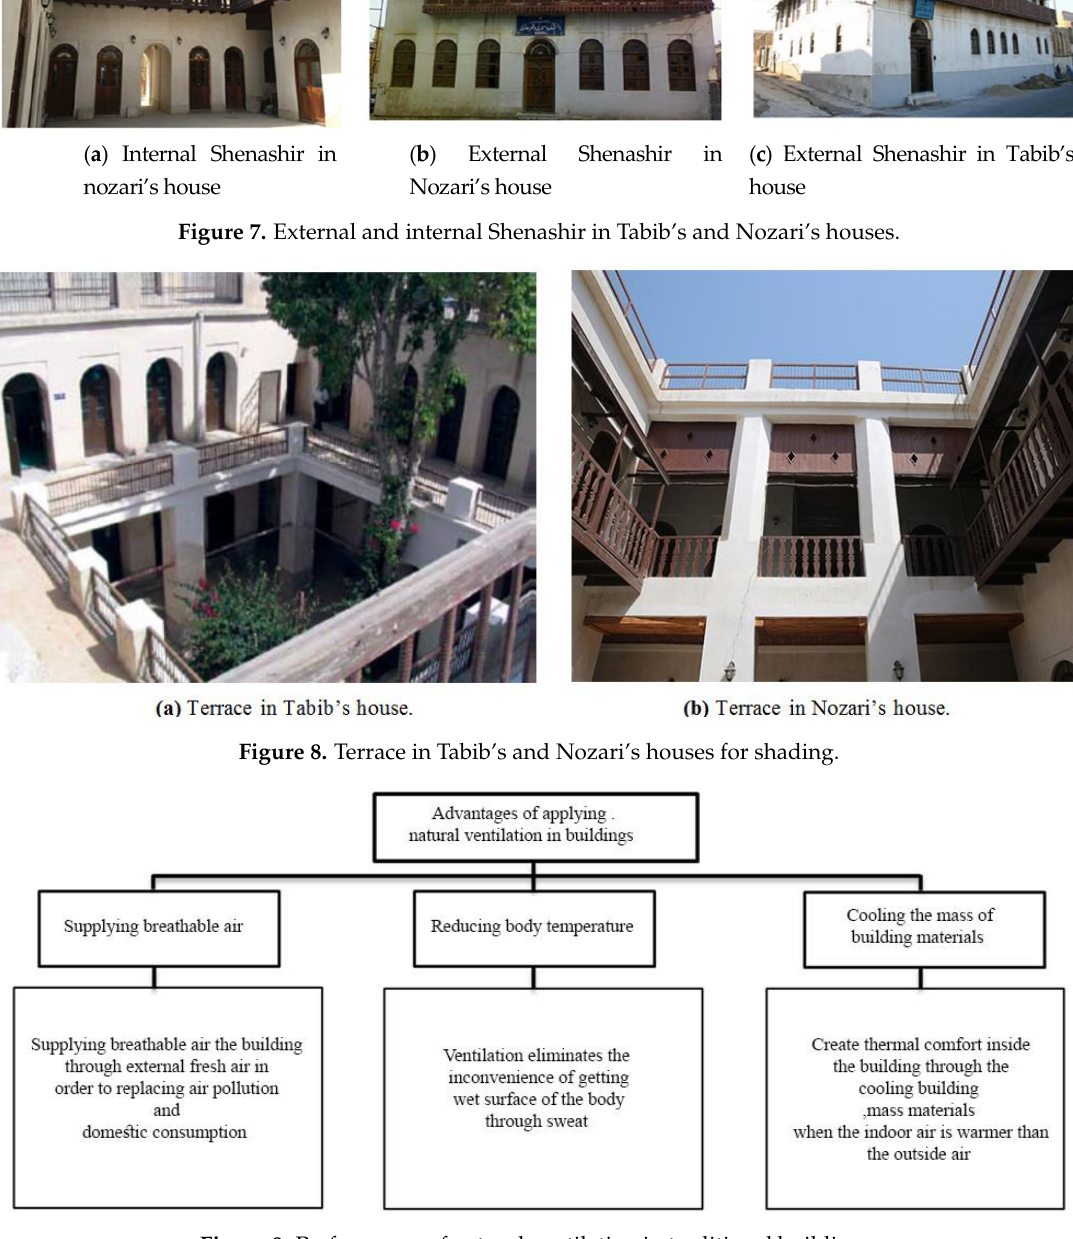
Figure 9. Performance of natural ventilation in traditional buildings.